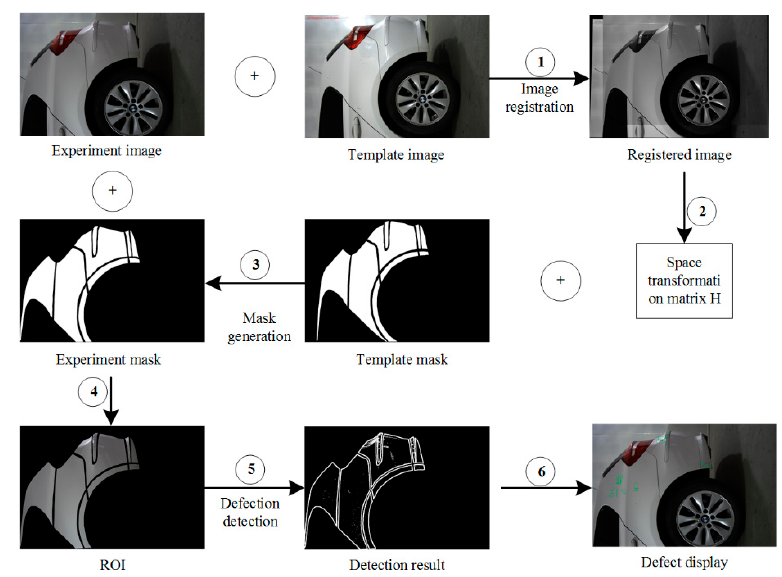
Figure 7. Examples of detection of ROI defects detection procedure.